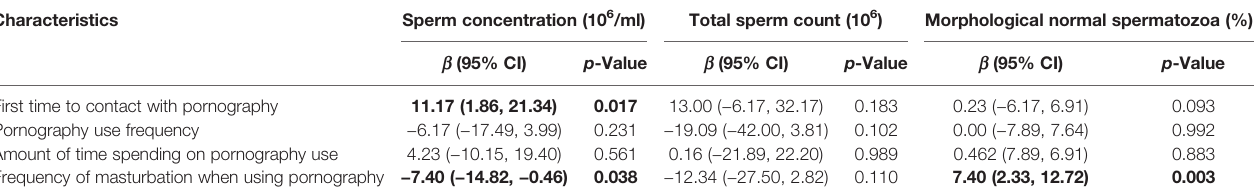
TABLE 5 | Associations between pornography use and semen parameters.